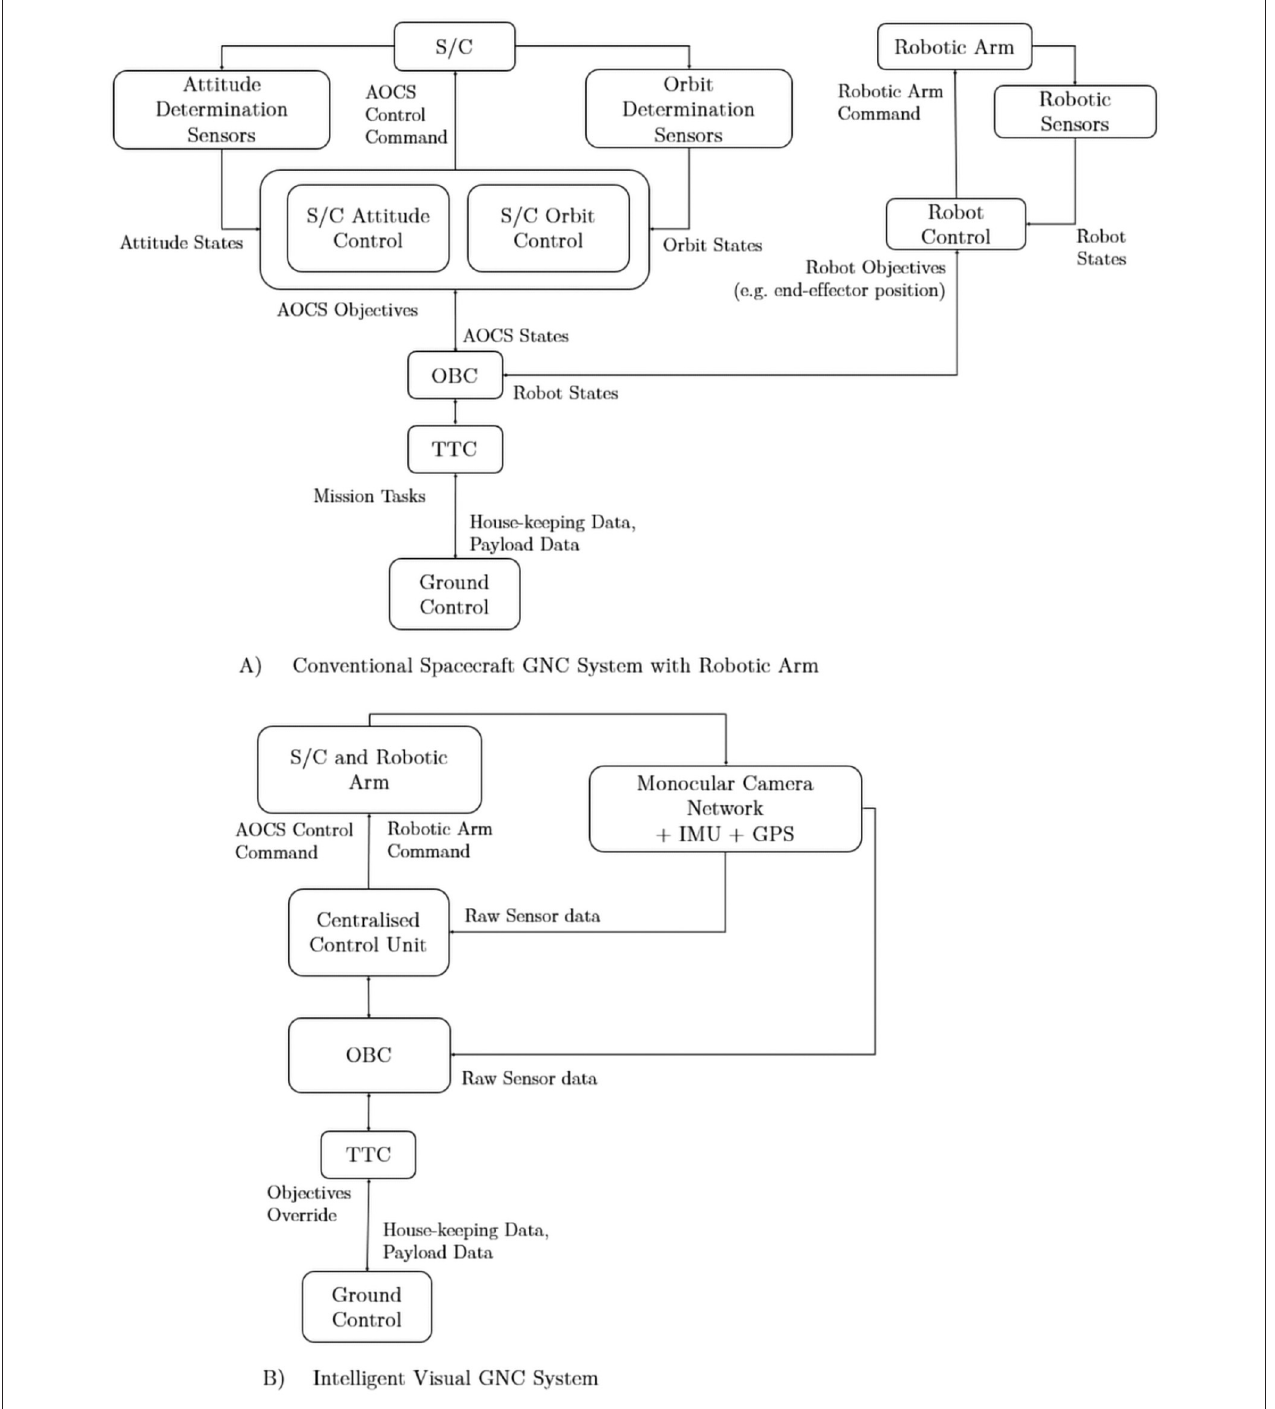
FIGURE 4 | The transition from (A) conventional spacecraft Guidance, Navigation, and Control (GNC) subsystem with robotic arm to (B) the Artificial Intelligence (AI) GNC subsystem. The AI GNC system uses centralized sensor information with primarily 2D images as inputs to the AI computer with pre-trained neural networks to control the spacecraft and robotic arm at the same